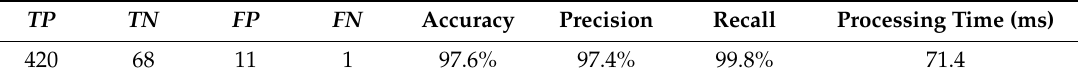
Table 5. Experiment